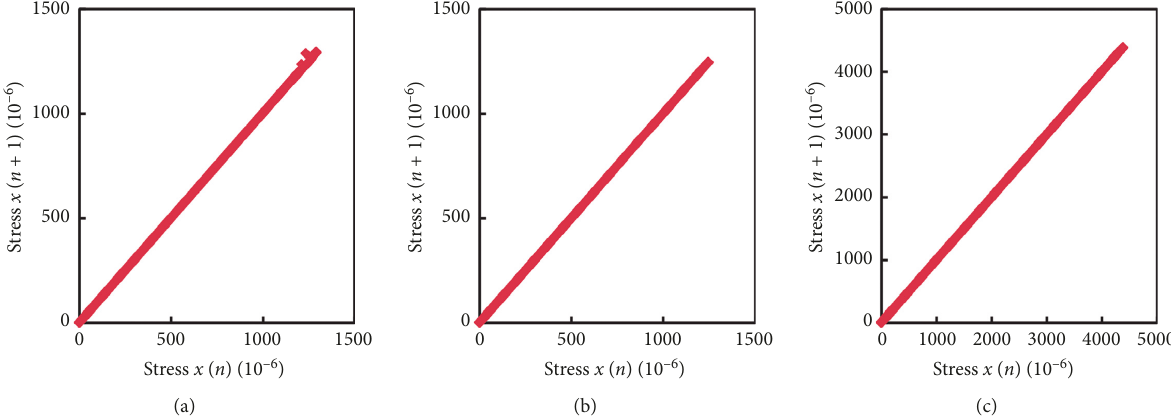
Figure 8: Evolution of each experimental strain series. (a) Sample of Group 1. (b) Sample of Group 2. (c) Sample of Group 3.